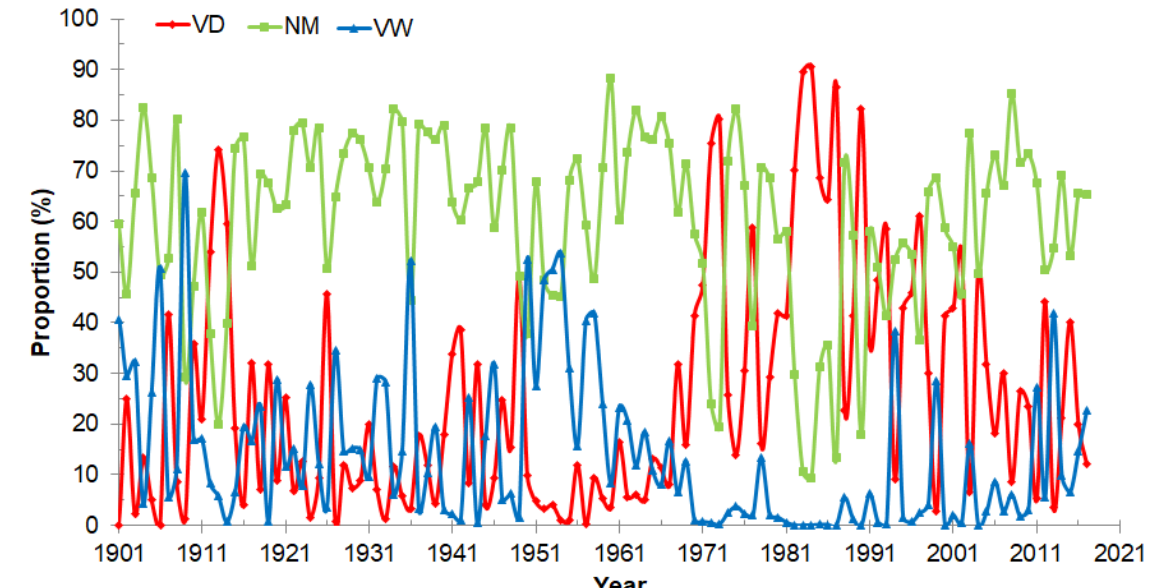
Figure 10. Proportion of grid points for the different type of year with UDEL_2017 data. VD: Very Dry, NM: Normal, VW: Very Wet. The curves represent the proportion of grid points that are under the corresponding climate condition.